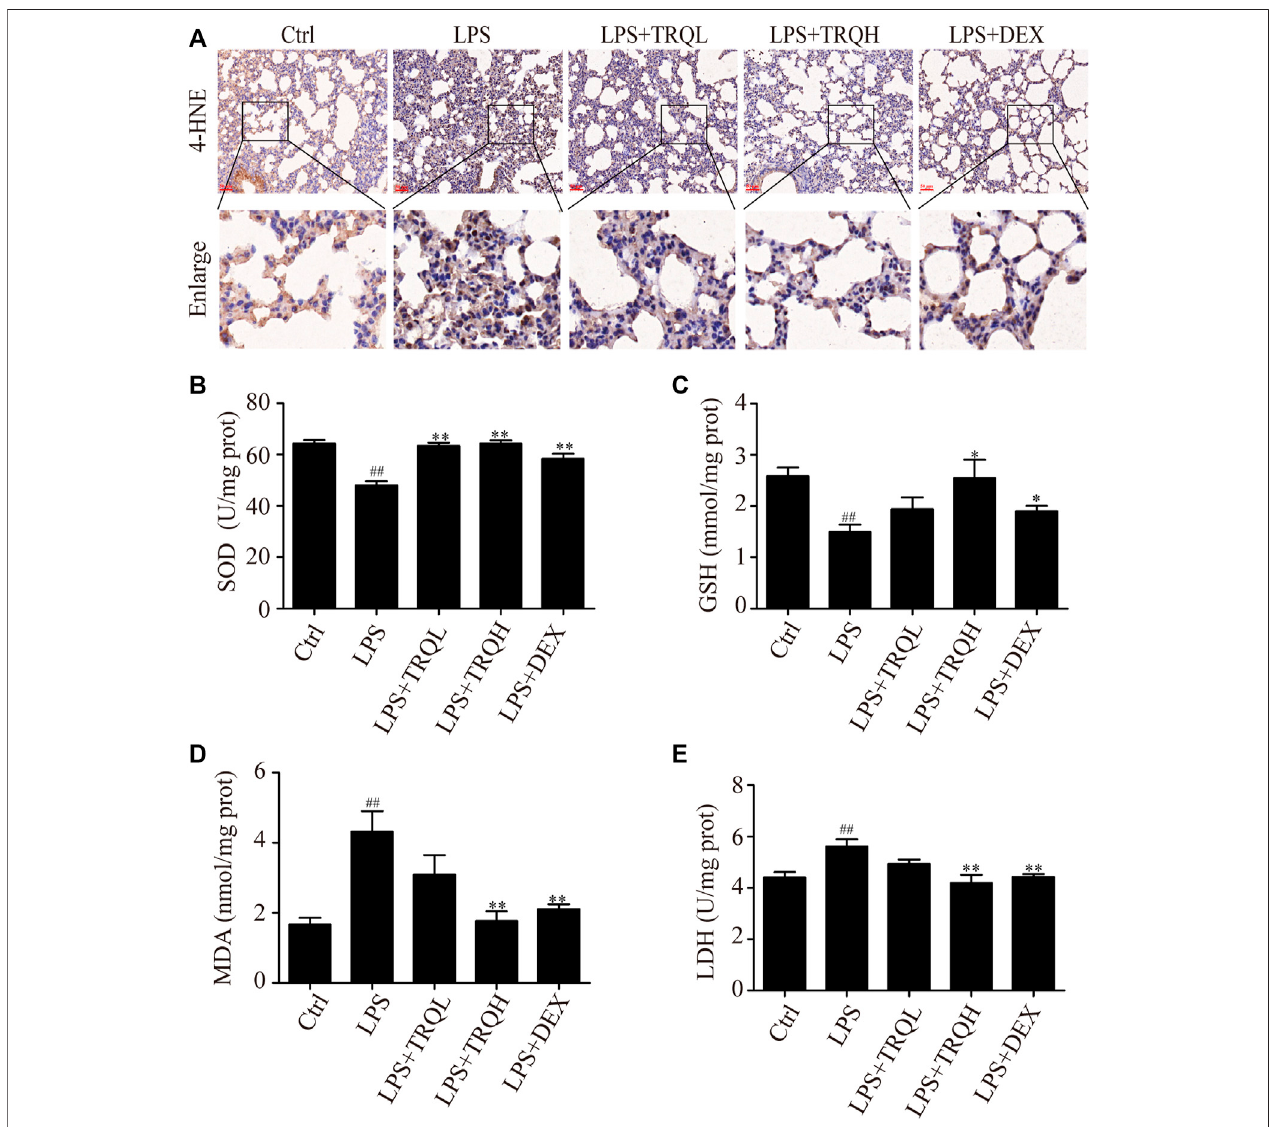
FIGURE5 | TRQ alleviated oxidative stressin LPS-inducedALI mice. (A) Theexpression of4-HNE in lung tissues. (B) SOD activity in lung tissues. (C) GSH activity in lung tissues. (D) MDA activity in lung tissues. (E) LDH activity in lung tissues. n (cid:2) 5 – 6. ## p < 0.01 vs. Ctrl group; *p < 0.05 and ** p < 0.01 vs. LPS group, respectively.